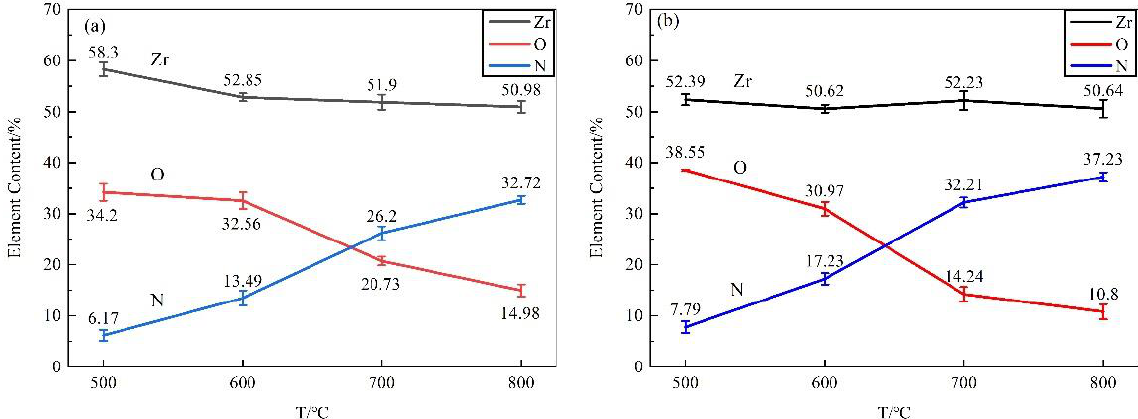
Figure 4. EDS analysis results of surface of zirconium hydride with nitride film ( a ) N 2 atmosphere; ( b ) N 2 + H 2 atmosphere.